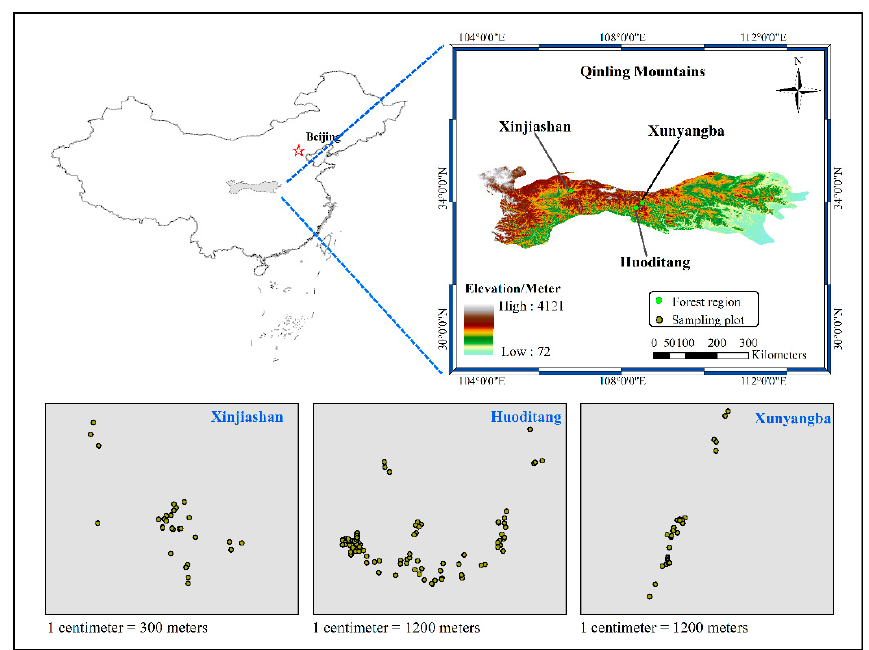
Figure 1. Locations of sampling plots.